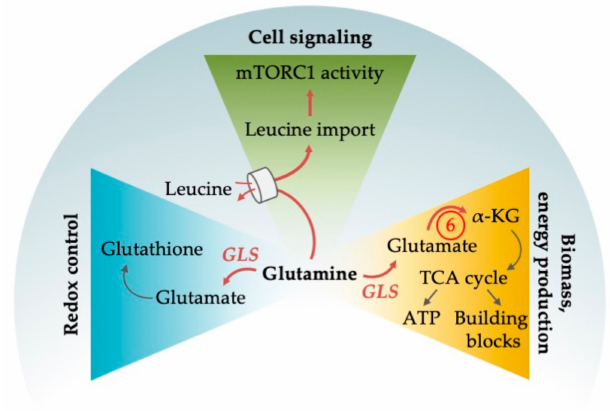
Figure 4. Glutamine plays an essential role in AML for di ff erent cellular functions. The amino acid supports redox control by providing the antioxidant glutathione and is involved in cell signaling by indirectly activating the central metabolic regulator mTORC1. Glutamine is further involved in energy production by replenishing the cells’ power hub, the tricarboxylic acid (TCA) cycle. In order to use glutamine both for redox control and energy production, glutamine is broken down into glutamate by glutaminase (GLS) which is found upregulated in AML. Enzymes that are dysregulated in AML are marked in red letters and with red arrows. Abbreviations: ATP, adenosine triphosphate; α -KG, α -ketoglutarate; mTORC1, mammalian target of rapamycin complex 1; NEAA, non-essential amino acids. Circled numbers refer to metabolic response determinants in AML that are explained in the Conclusion